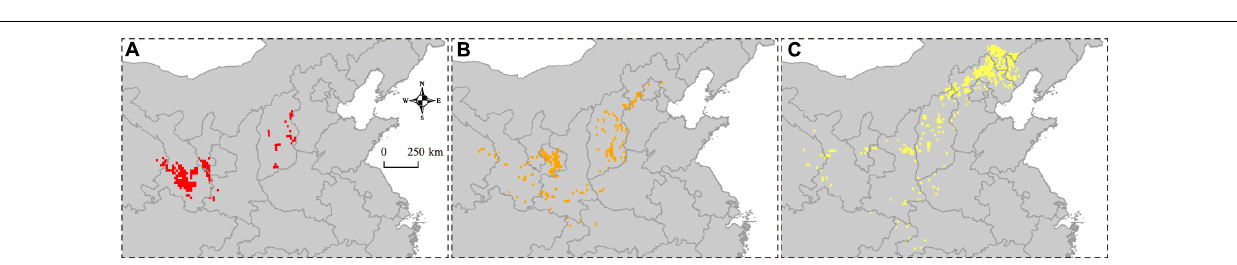
FIGURE 5 | Suitability overlaying the current (2000–2016) and future (2050 and 2100 A1B and A2 SRES scenarios) potential distributions of B. pyrosoma. (A) High suitability over current and future potential distributions. (B) Moderate suitability over current and future potential distributions. (C) Low suitability over current and future potential